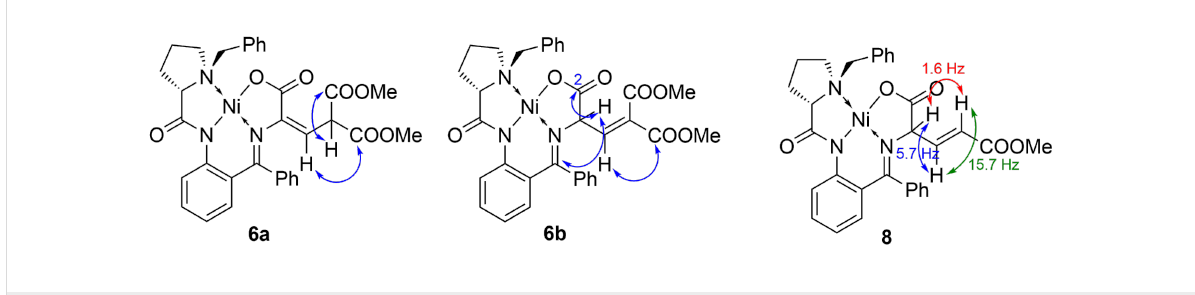
Figure 3: Correlations in the HMBC spectra of 6a and 6b and spin coupling constants in the 1 H NMR spectrum of 8 .